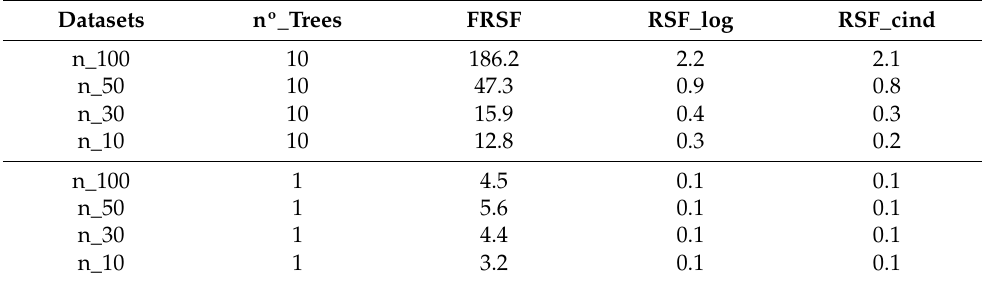
Table 8. Computational Time for Different Datasets and Number of Trees.